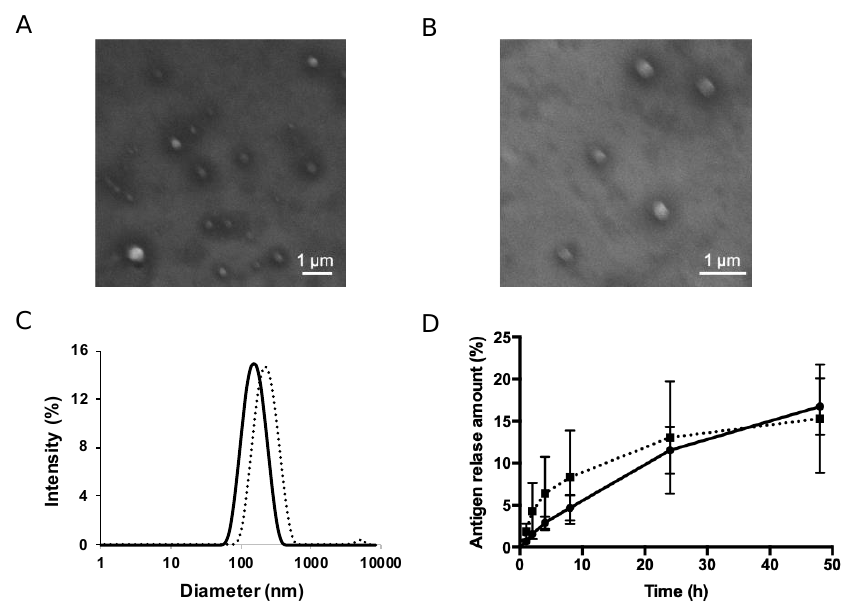
Figure 2. Characterization of solid-in-oil (S / O) nanodispersions. SEM images of S / O nanoparticles loaded with ( A ) pollen extract (PE) and ( B ) pollen extract-galactomannan conjugate (PE-GM). ( C ) Particle size distribution in PE-S / O nanoparticles (solid line) and PE-GM-S / O nanoparticles (dotted line) nanodispersions. ( D ) Release of PE (solid line) and PE-GM (dotted line) from the S / O nanodispersions. n = 4, mean ± SE. Table 1. Size analysis of S/O nanoparticles loaded with pollen extract (PE) or pollen extract- galactomannan conjugate (PE-GM).